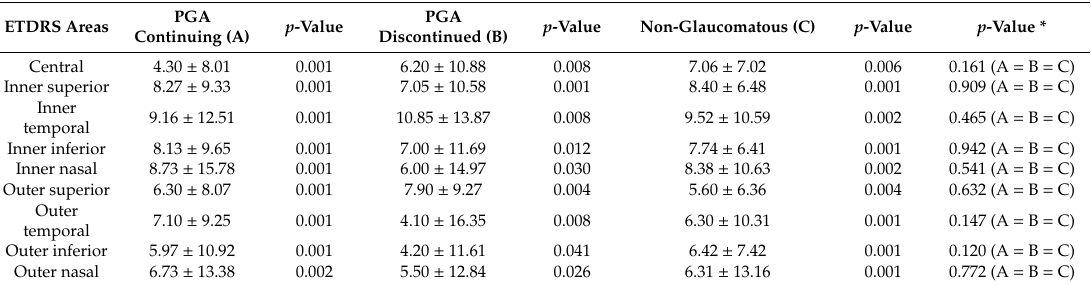
Table 4. Comparison of postoperative changes in macular thickness among the PGA continuing, PGA discontinued, and non-glaucomatous